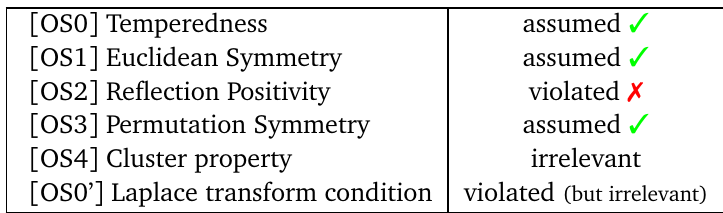
Table 2: OS axioms for Schwinger functions in the Euclidean